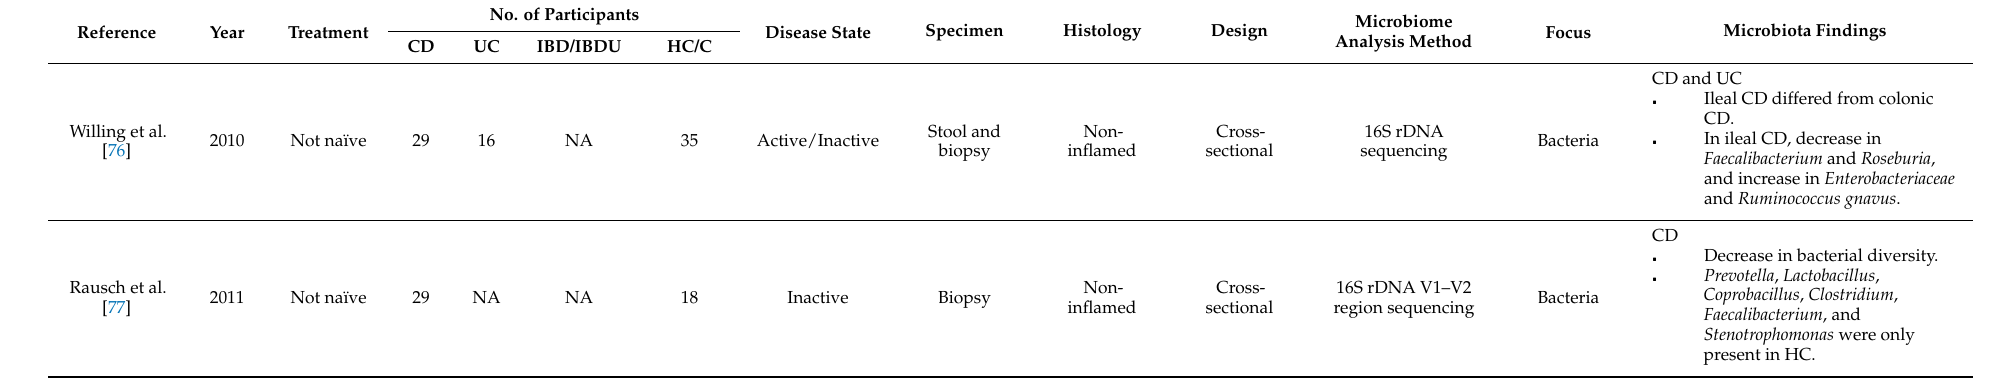
Table 2. Gut microbiome studies in inflammatory bowel disease using next-generation sequencing